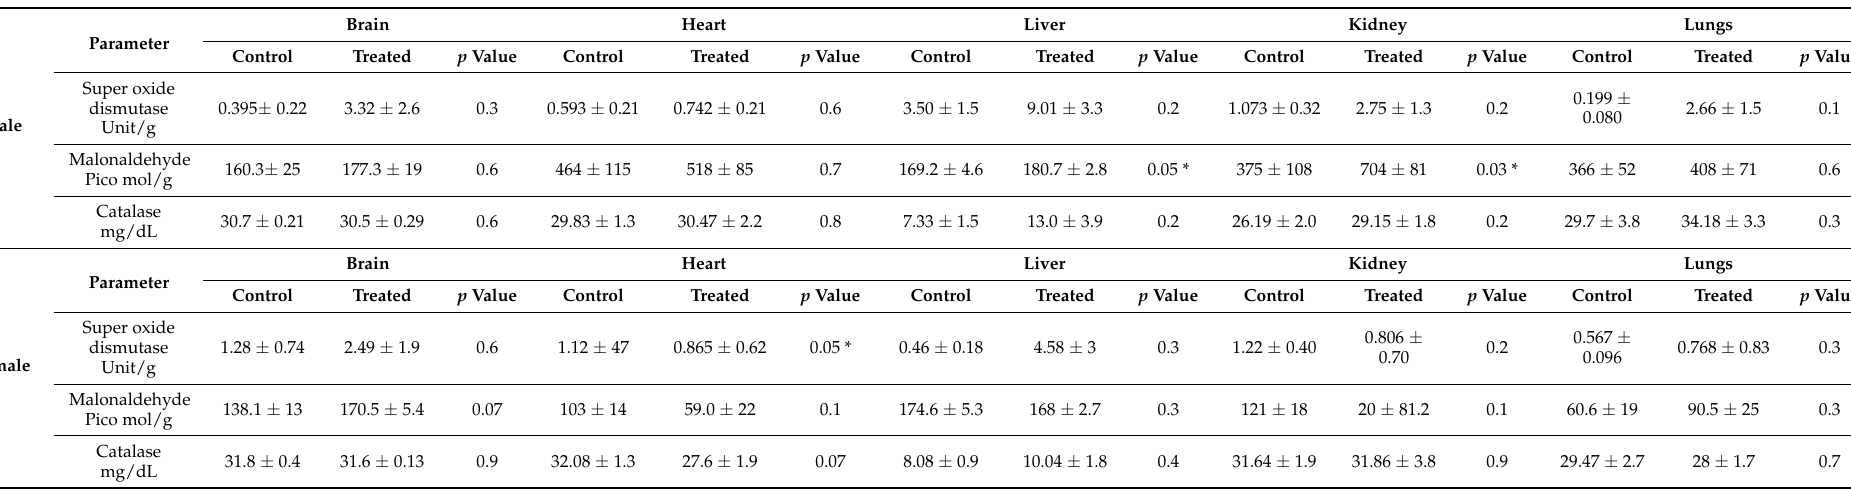
Table 3. Comparison of various studied antioxidant parameters between male/female albino mice supplemented orally for 11 days either with saline solution or 10 mg/mL solvent/KgKg body weight of Neodymium zirconate zinc sulfide nanocomposite. All values are expressed as mean ± slandered error of mean. p -value presents the results for the 2-sample t -test calculated for each